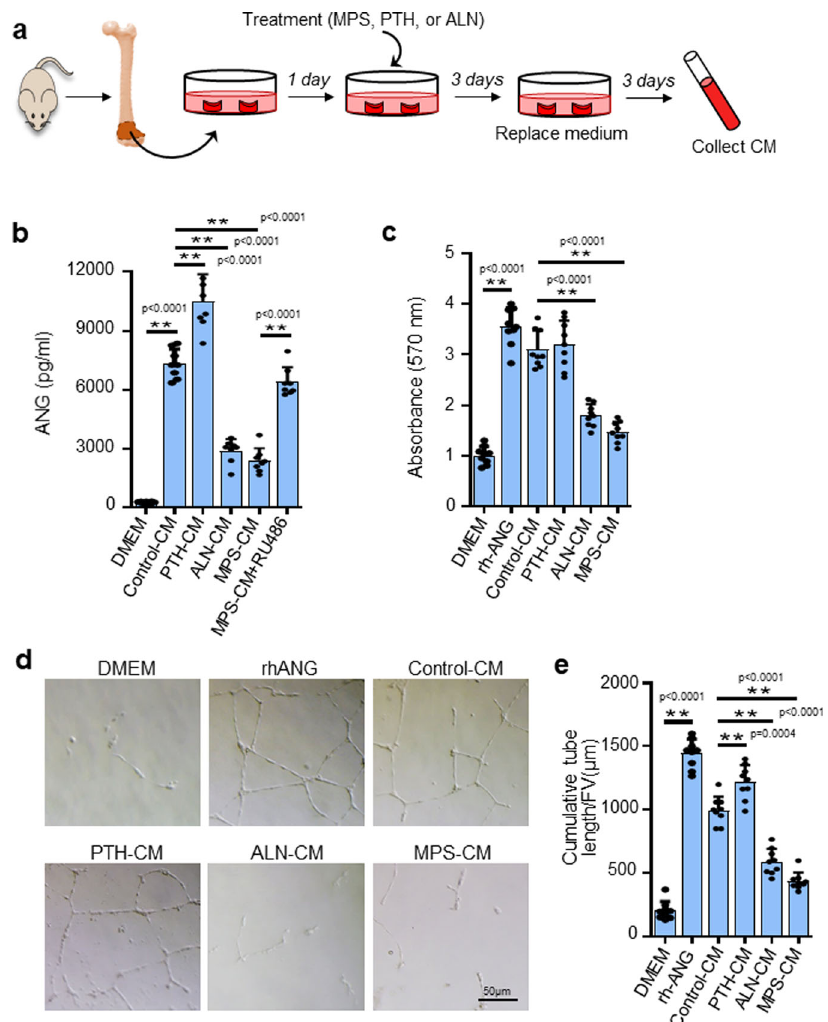
Fig. 6 ANG secreted from metaphyseal osteoclasts mediates osteoclast-vascular crosstalk. a Schematic diagram showing the procedure of the ex vivo experiments. Metaphyseal bone of distal femur was isolated from 3-week-old C57BL/6J mice and cultured in serum-free DMEM for 1 day to adjust to the ex vivo environment. The explant was then cultured for 3 days with different treatments. Fresh medium was replaced after washing away the medium. Conditioned medium (CM) was collected after another 3-day culture. b The concentrations of ANG in the CMs were measured by ELISA. c Different CMs were individually added in the HUVEC culture, and the proliferation of the cells was measured by MTT assay. d and e Different CMs were individually added in the HUVEC culture planted on Matrigel. Tube formation assay images are shown in ( d ). Quantitative analysis of cumulative tubule length is shown in ( e ). PTH parathyroid hormone, ALN alendronate. Experiments were performed in triplicate and were repeated three times. Data are represented as mean ± s.e.m. ** p < 0.01 as determined by one-way ANOVA with post hoc Tukey